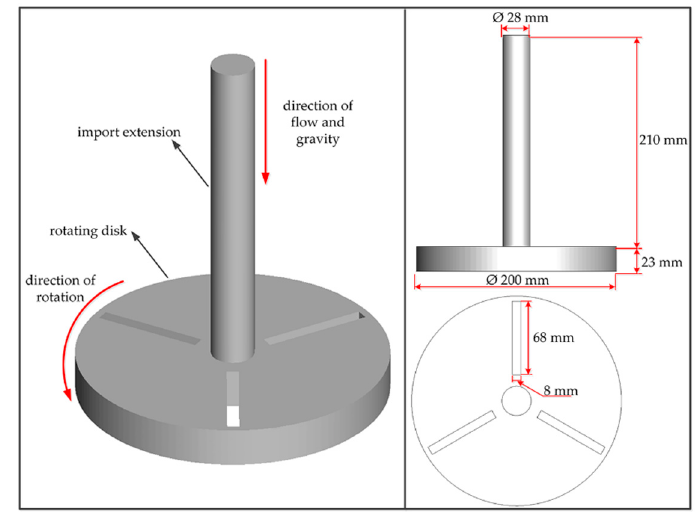
Figure 5. Computational domain of the centrifugal slurry pump.